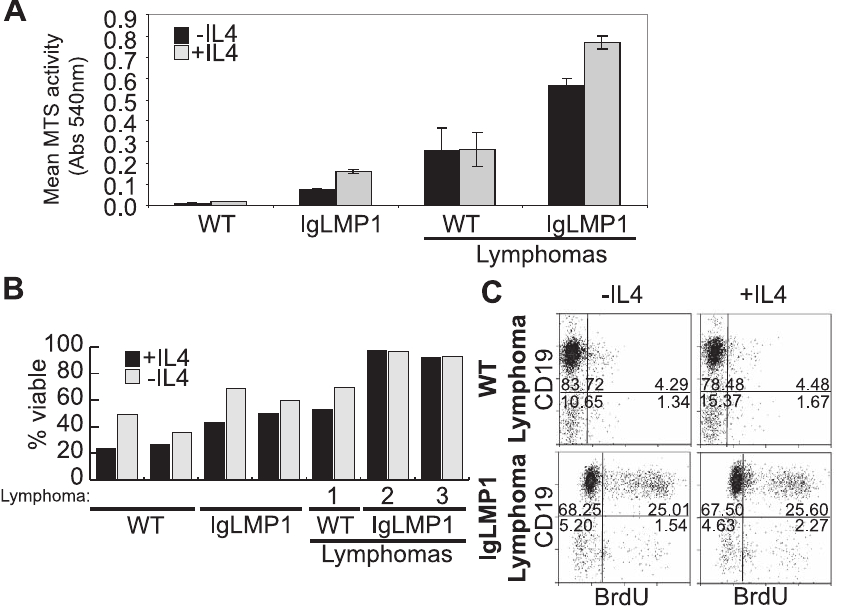
Figure 3. LMP1 Promotes B Cell Survival and Proliferation In Vitro (A) MTS assay of splenocytes from WT and LMP1 transgenic mice. Splenocytes were cultured in the presence (grey bars) or absence (black bars) of IL4 for 3 d. The results are the mean 6 SEM of triplicate samples averaged from multiple mice where ‘‘ n ’’ the number of mice analyzed is as follows: n ¼ 2 for WT lymphocytes and WT lymphomas, n ¼ 11 for LMP1 transgenic lymphocytes, and n ¼ 13 for LMP1 transgenic lymphomas. (B) EMA exclusion of CD19 þ gated splenocytes from WT and LMP1 transgenic mice showing percentage of viable B cells cultured with (white bars) or without (black bars) IL4 for 2 d. (C) Flow cytometry analysis for incorporated BrdU in WT and LMP1 transgenic lymphoma cells cultured with or without IL4 for 2 d. Shown are the results